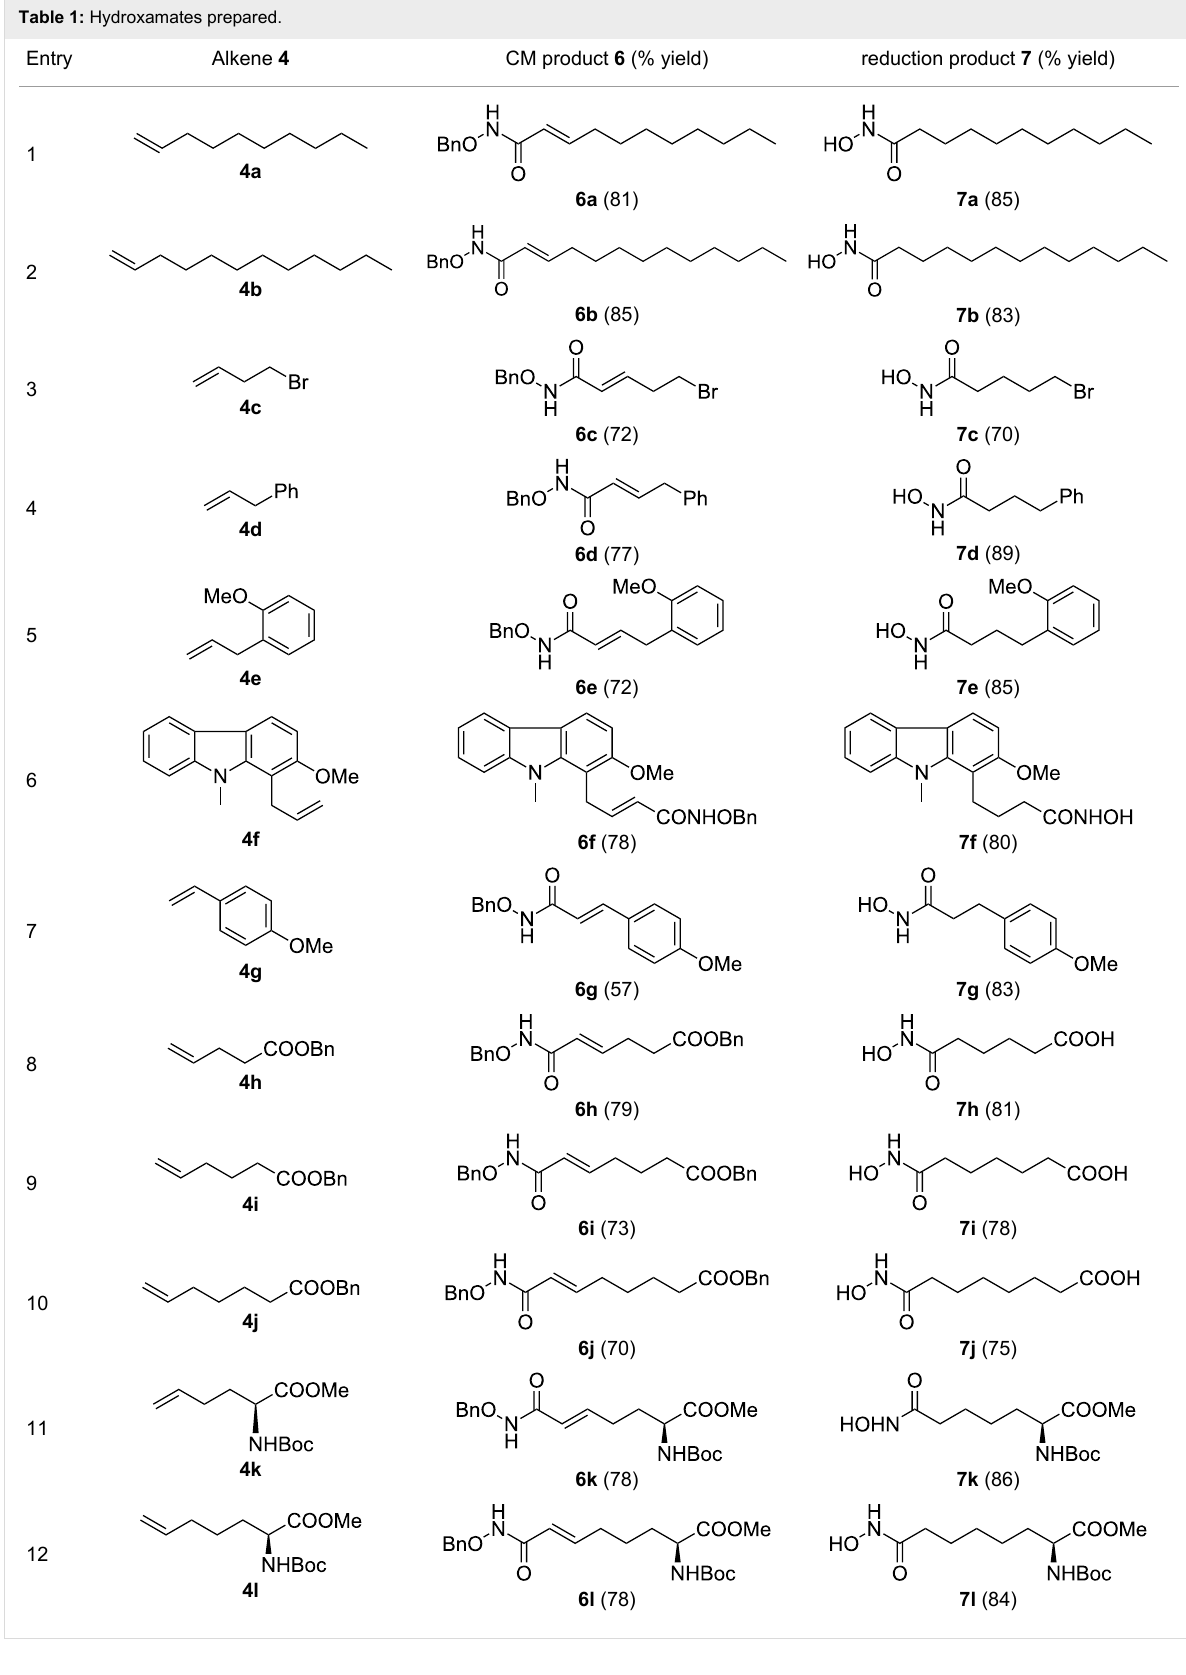
Table 1: Hydroxamates